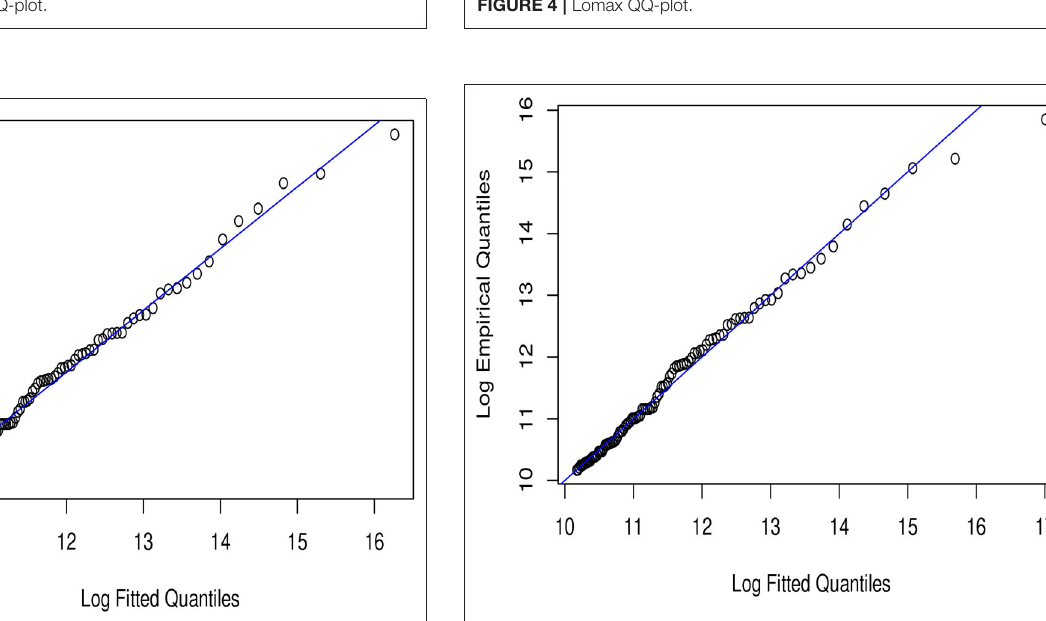
FIGURE 2 | Frechet QQ-plot.